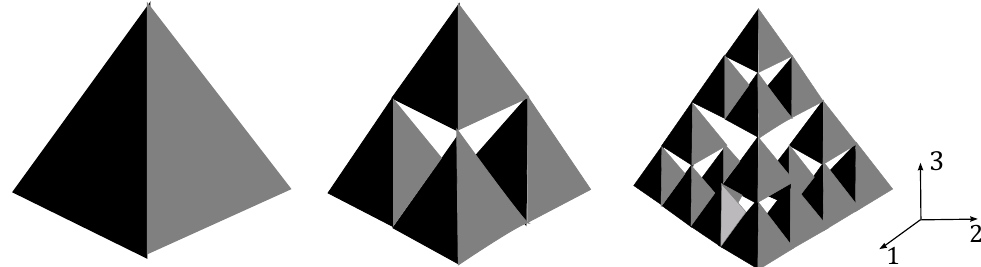
Figure 1. Schematic representation of a Sierpinski tetrix sensor at fractal generation levels one, two and